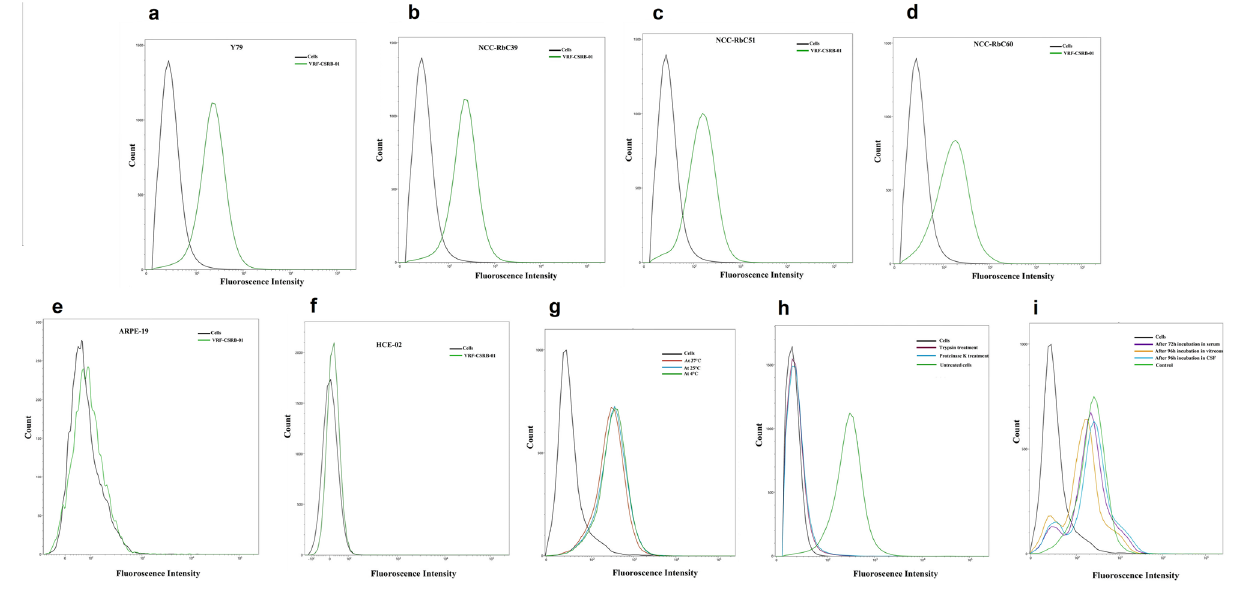
Figure 4. Binding ability and characterization of the selected aptamer VRF-CSRB-01. ( a – d ) The binding ability of VRF-CSRB-01 to RB cell lines Y79, NCC-RbC39, NCC-RbC51 and NCC-RbC60 respectively analysed by flow cytometry. ( e ) The binding ability of VRF-CSRB-01 to retinal pigment epithelial (ARPE-19) cell line. ( f ) The binding ability of VRF-CSRB-01 to corneal epithelium (HCE-02) cell line ( g ) Effect of incubation temperature on the binding ability of VRF-CSRB-01 with Weri-RB1 cells. The cells were incubated with FITC- labelled VRF-CSRB-01 at 4 °C, 25 °C and 37 °C and analysed by flow cytometry. ( h ) Binding ability of aptamer VRF-CSRB-01 with Weri-RB1 cells treated with trypsin or proteinase-K. The cells were treated with trypsin or proteinase K at 37 °C for 5 min and then incubated with FITC-labelled VRF-CSRB-01 aptamer and analysed by flow cytometry. ( i ) The binding ability of aptamer recovered from the biological fluid’s serum, vitreous and CSF after 72 and 96 h respectively.